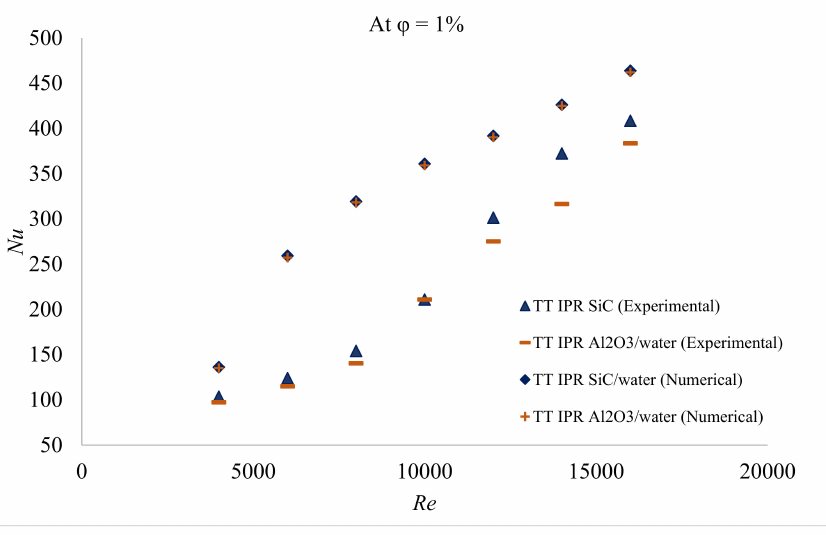
Figure 22. E ff ects of the type of nanoparticles on